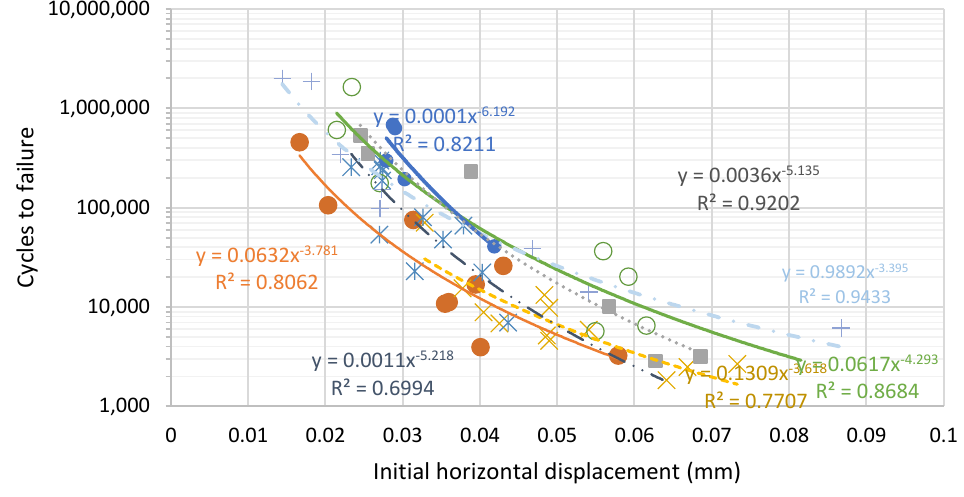
Figure 9. Fatigue laws measured in the cores obtained along the service life of the highway sections studied.